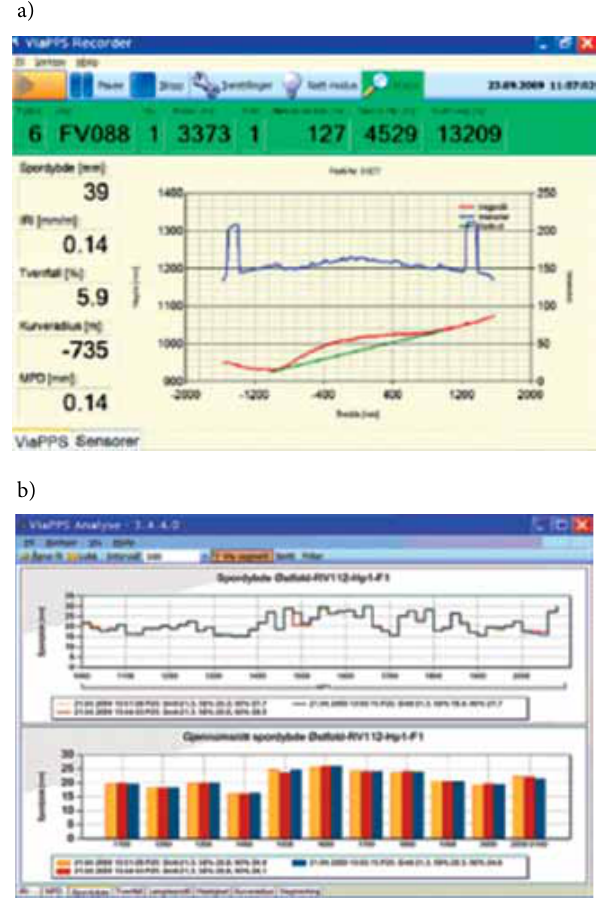
Fig. 3. ViaTech ViaPPS Analysis Screen shots illustrating: